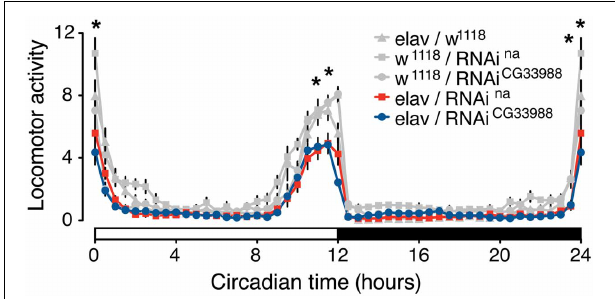
FIGURE 3 | Targeted RNAi knockdown of na or CG33988 expression disrupts diurnal control of locomotor behavior. UAS-responsive RNAi against na or CG33988 were pan-neurally driven using the elav-Gal4 driver. Control flies carry the elav-Gal4 driver in the w 1118 background used for the UAS-RNAi lines, but lacked the UAS-RNAi transgene. The locomotor activity of each genotype was monitored for a 7-day period and daily averages plotted in 30-minute bins. White bar at the X-axis indicates day period, black bar indicates night period. Asterisks indicate statistically significant difference between the induced-RNAi groups and the control groups for the individual 30-min bins ( ∗ P < 0 . 05, repeated measures Two-Way